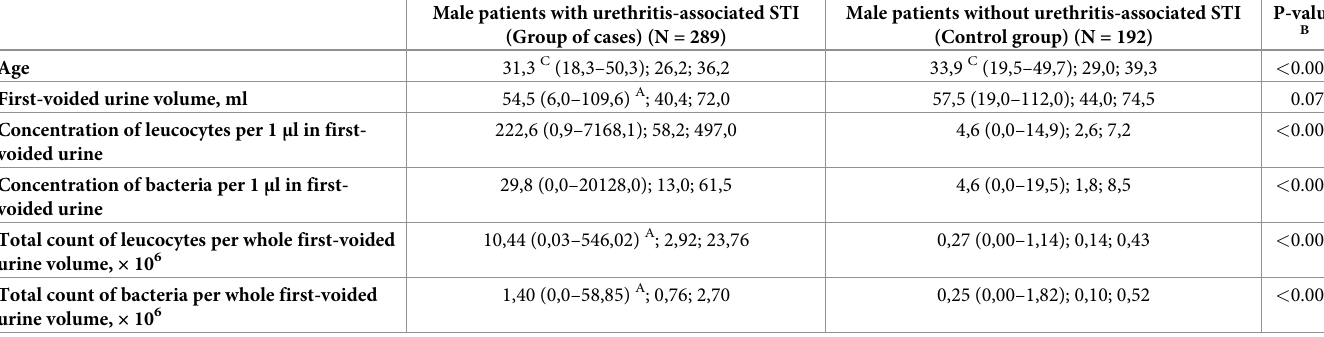
Table 2. Basic parameters of study subjects (median (range); 25 th centile; 75 th centile).